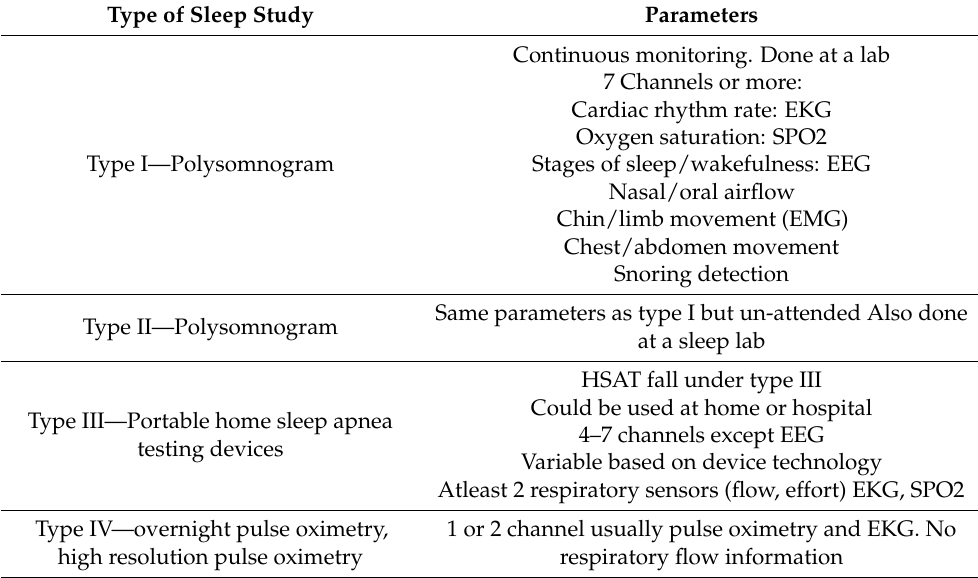
Table 2. Classification of sleep studies. Type of Sleep Study Parameters Type I—Polysomnogram Type II—Polysomnogram